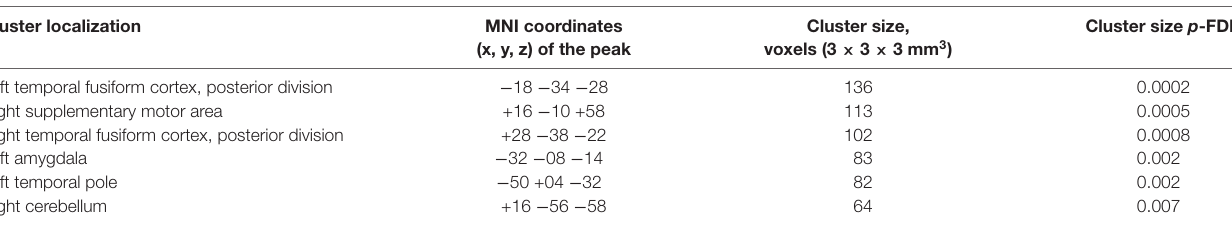
TABLE 1 | Clusters showing increased intrinsic connectivity after